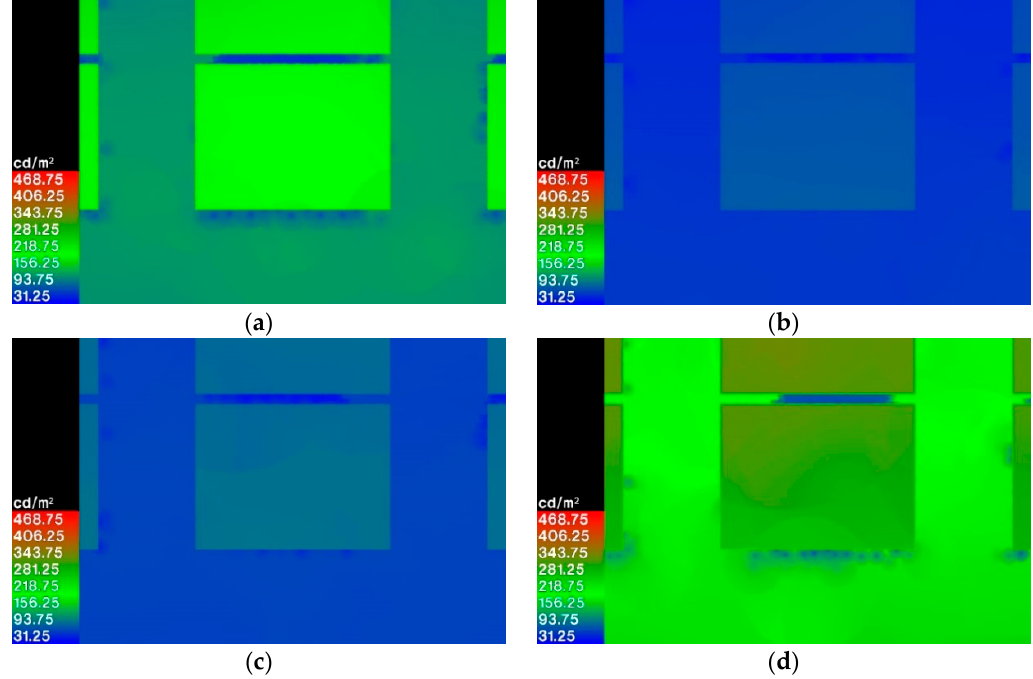
Figure 11. The luminance distribution at Viewpoint 3 of daylighting through different window types: ( a ) flat skylight; ( b ) low side window; ( c ) high side window; ( d ) sawtooth skylight.